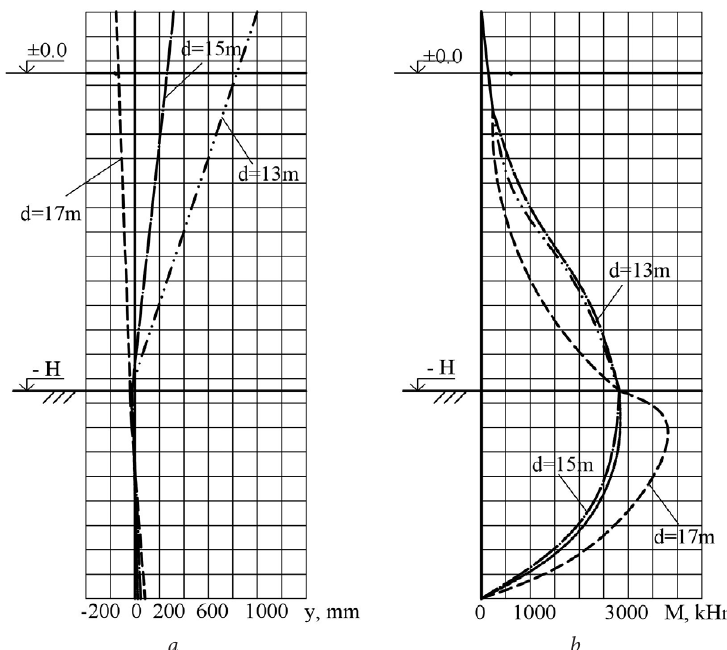
Fig. 3. Schemes for the calculation of the wall when the buttress height is changed: a – diagrams of wall movements; b – diagrams of bending moments in the